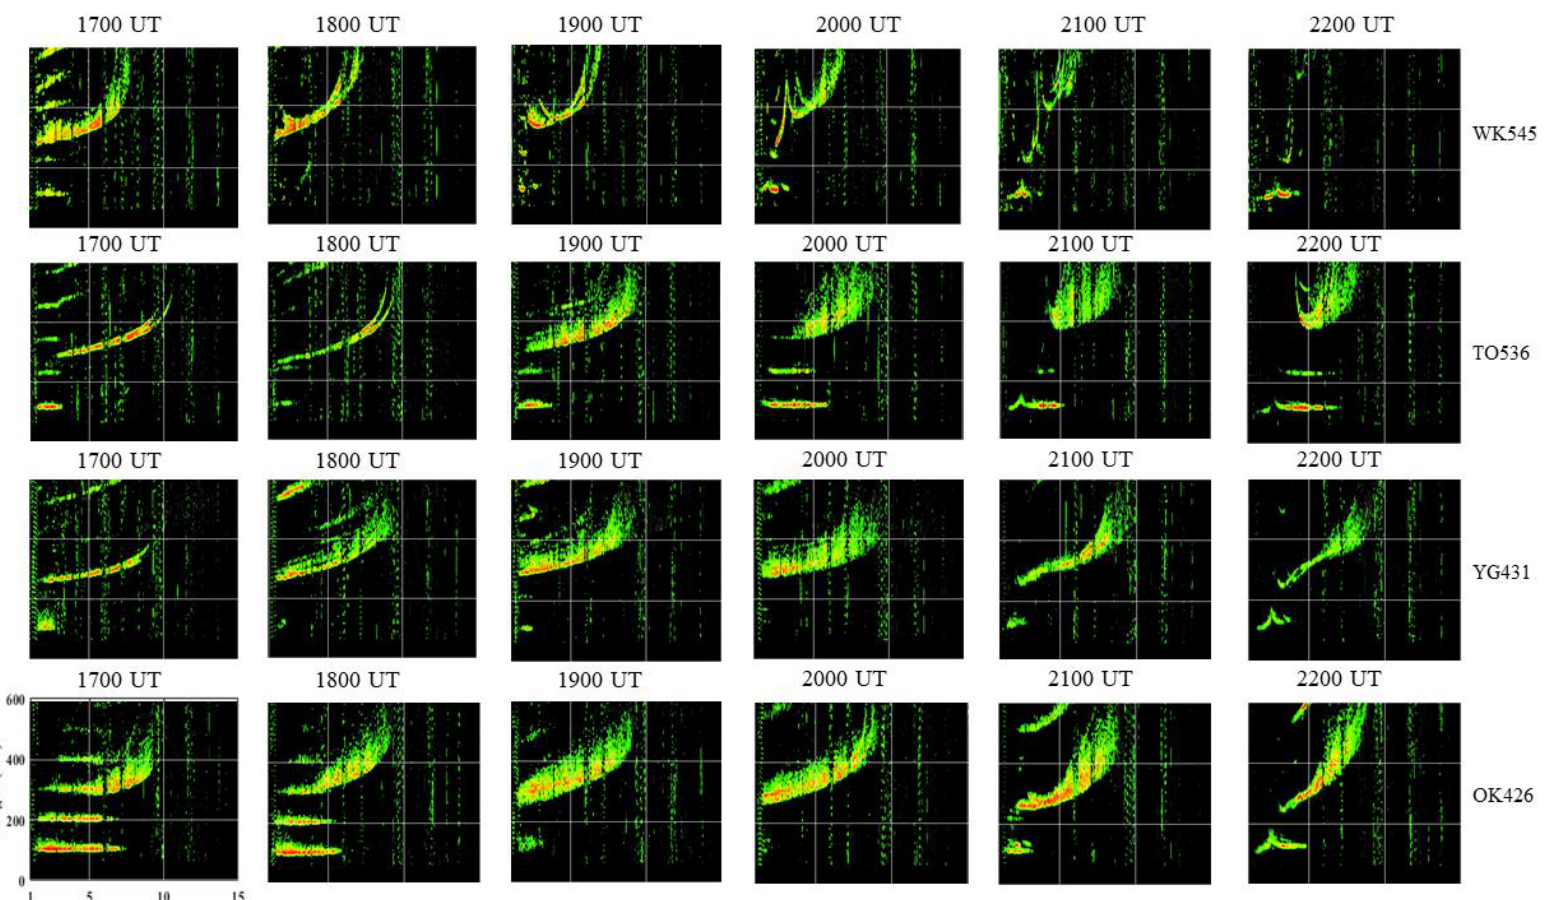
Figure 4. Development of spread F at ( top panel ) WK545, ( second panel ) TO536, ( third panel ) YG431, and ( bottom panel ) OK426 during 17–22 UT (02-07 JST) on 16 July 2003. Coordinate reference information is given in the lower left figure.